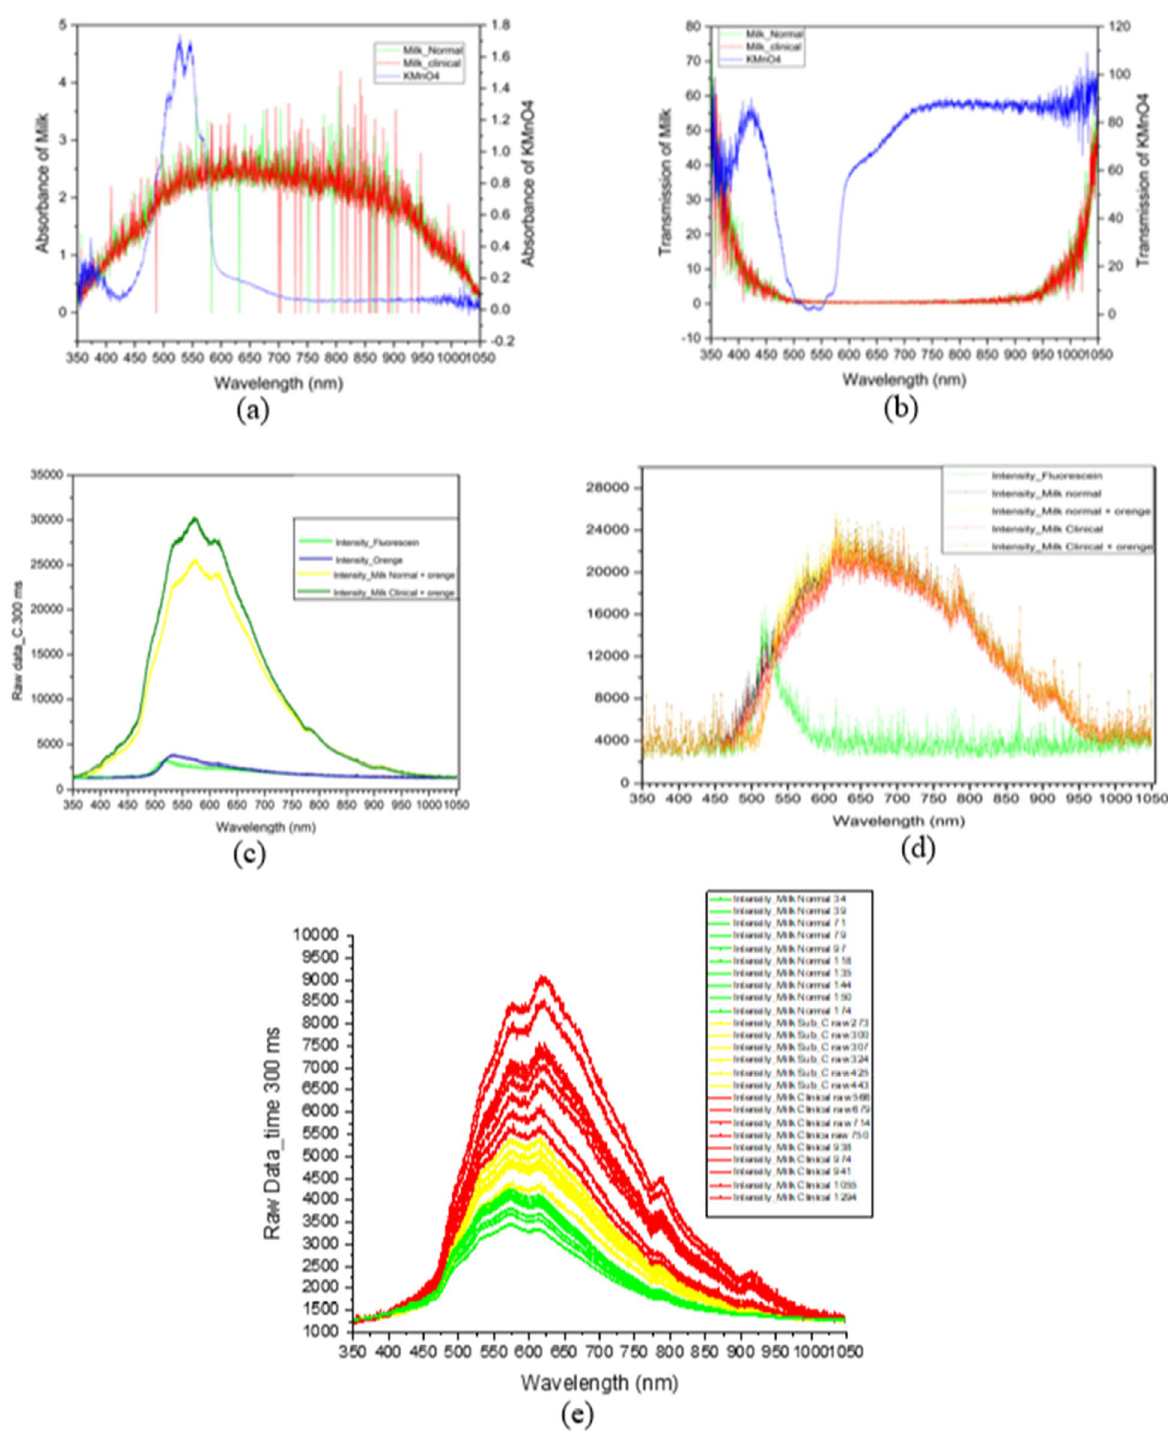
Figure 8. The testing milk and KMnO 4 in the microfluidic chip ( a ) absorbance mode and ( b ) transmittance mode. ( c ) Testing 0.01 M Fluorescein, AO, and a mix of milk and AO in microfluidic chip fluorescence mode. ( d ) Testing 0.01 M Fluorescein, AO, and a mix of milk and AO in the standard equipment (cuvette) ( e ) comparison of accuracy under microfluidic device and Fossomatic cell counting instrument. The red line shows the clinical milk, the yellow line shows the sub-clinical milk, and the green line shows the normal